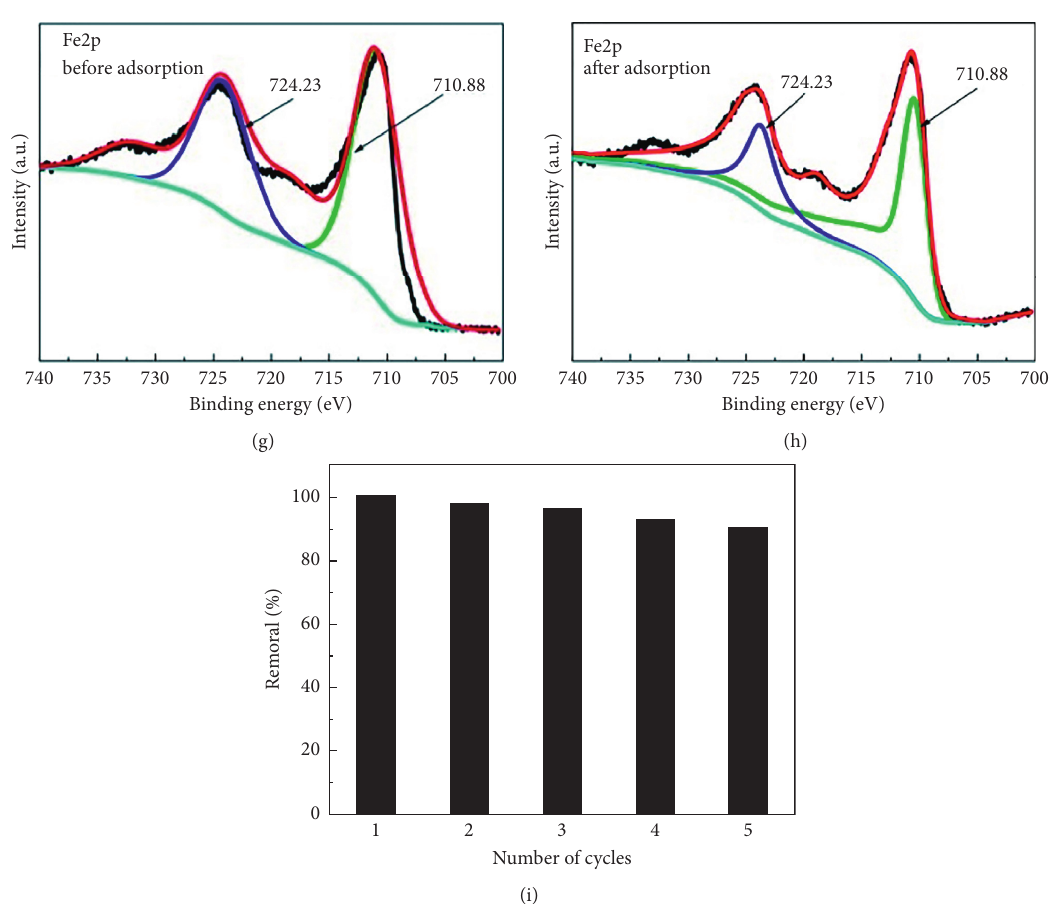
Figure 14: XPS spectra (a) of Fe 3 O 4 /PPy nanotubes before and after adsorption of Cr(VI), high-resolution spectra of Cr2p (b) after adsorption of Cr(VI). XPS spectra of O1 s(c, d), N1s (e, f), and Fe2p (g, h) for Fe 3 O 4 /PPy nanotubes before and after adsorption of Cr(VI), and (i) adsorption and desorption cycles of Fe 3 O 4 /PPy